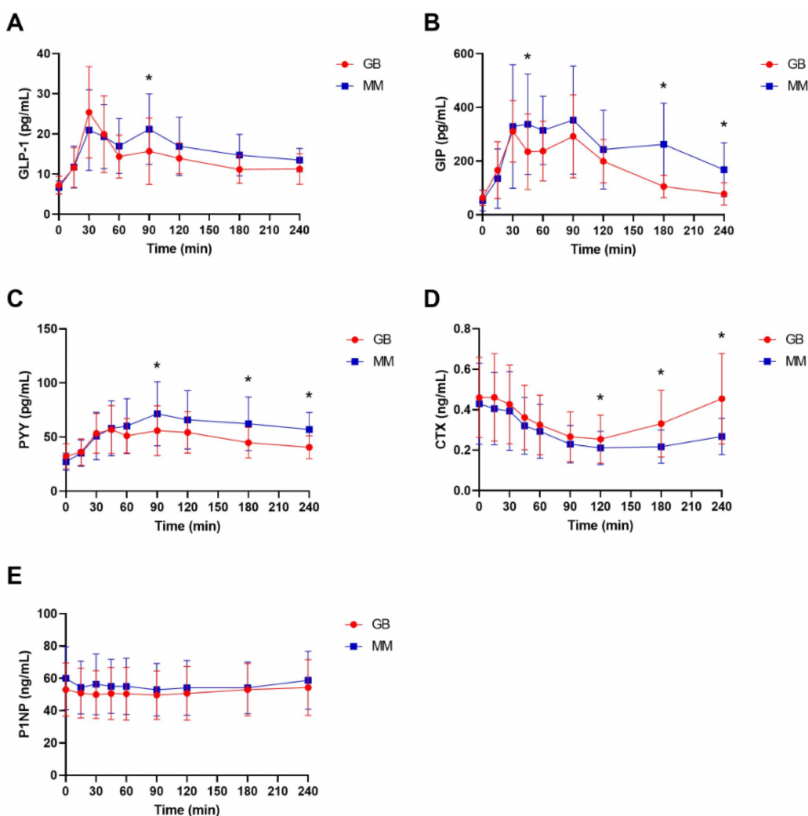
Figure 1. Mean ( ± SD, standard deviation) postprandial plasma concentrations of the gut hormones GLP-1 (glucagon-like peptide) ( A ), GIP (glucose-dependent insulinotropic polypeptide) ( B ), and PYY (peptide YY) ( C ) and the bone remodeling markers CTX (carboxyl-terminal collagen type I crosslinks) ( D ) and P1NP ( E ) for the two types of meals (granola bar and standardized mixed meal (MM)), n = 14. Significant differences between the two groups at individual time points are marked by * and denote p < 0.05. GB, granolabar, MM, mixed meal.